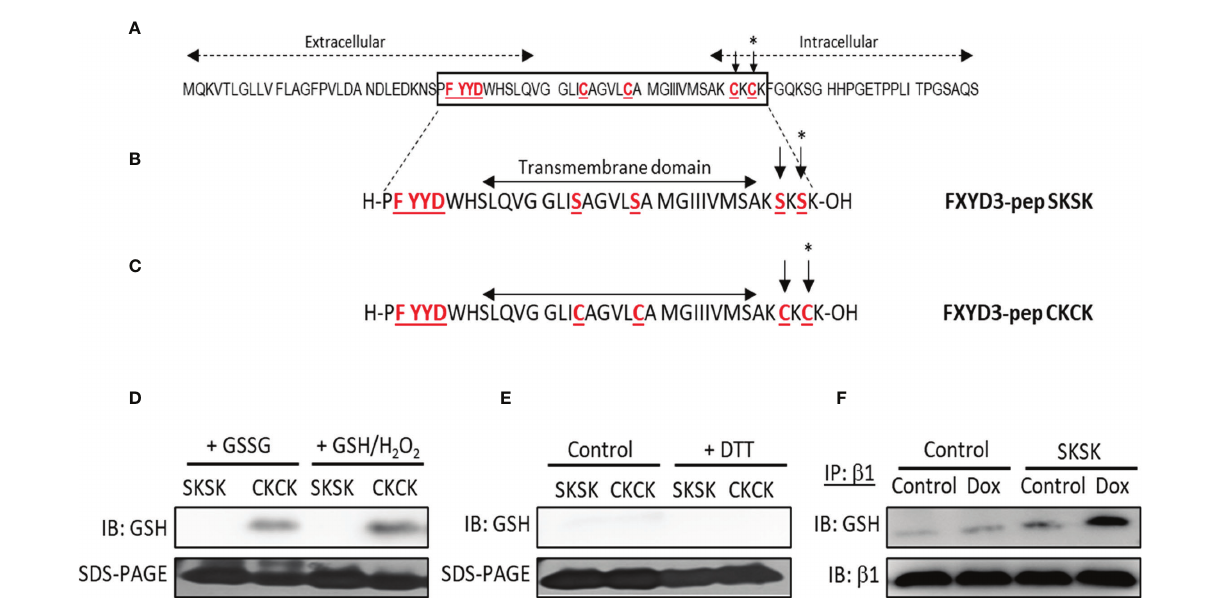
FIGURE 2 | Amino acid sequences of FXYD3 and its derivatives. (A) Wild-type (WT) FXYD3. Cys residues mutated to Ser in full-length recombinant protein and the FXYD motif in the extracellular domain are shown in red font and are underlined. A Cys residue (indicated by *) in the cytoplasmic domain near the inner membrane lea fl et and bracketed by basic amino acids (here Lys) is obligatory for susceptibility to glutathionylation of members of the FXYD protein family. Such susceptibility is critical for a FXYD protein, including FXYD3, to counter glutathionylation of the b 1 Na + /K + -ATPase subunit. (B) Amino acid sequence of FXYD3-pep SKSK. Ser residues (indicated by *) that replaced Cys residues in the corresponding sites in WT FXYD3 are indicated in red font. (C) Amino acid sequence of FXYD3-pep CKCK that has Cys residues (indicated by *) of WT FXYD3 retained. (D) Immunoblots for GSH indicating glutathionylation of FXYD3-pep CKCK but not FXYD3-pep SKSK with exposure to GSSG or GSH/H 2 O 2 . (E) Reversibility of FXYD3-pep CKCK glutathionylation with exposure to DTT. (F) Immunoblot for GSH of cell lysate immunoprecipitated for the b 1 Na + /K + -ATPase subunit after exposure to Dox. Pre-exposure to FXYD3-pep SKSK augments Dox-induced b 1 Na + /K + -ATPase subunit